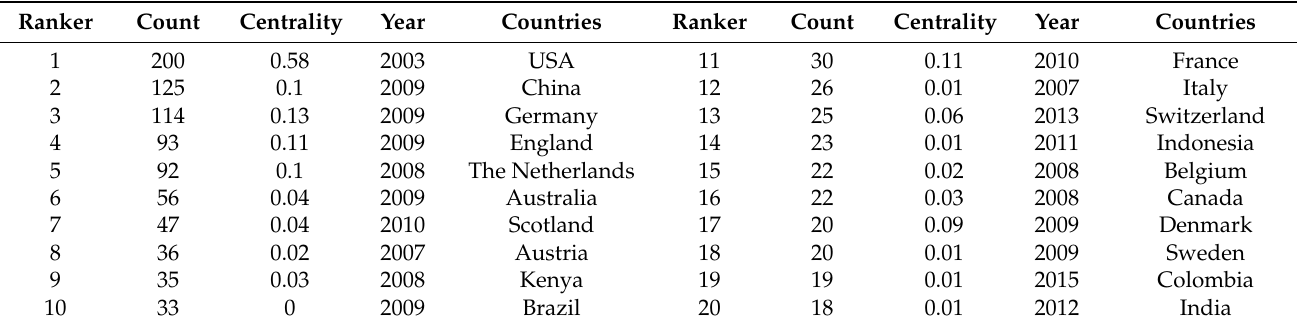
Figure 4. Country cooperation network map. Table 3. Information table of the top 20 major research countries with published articles.